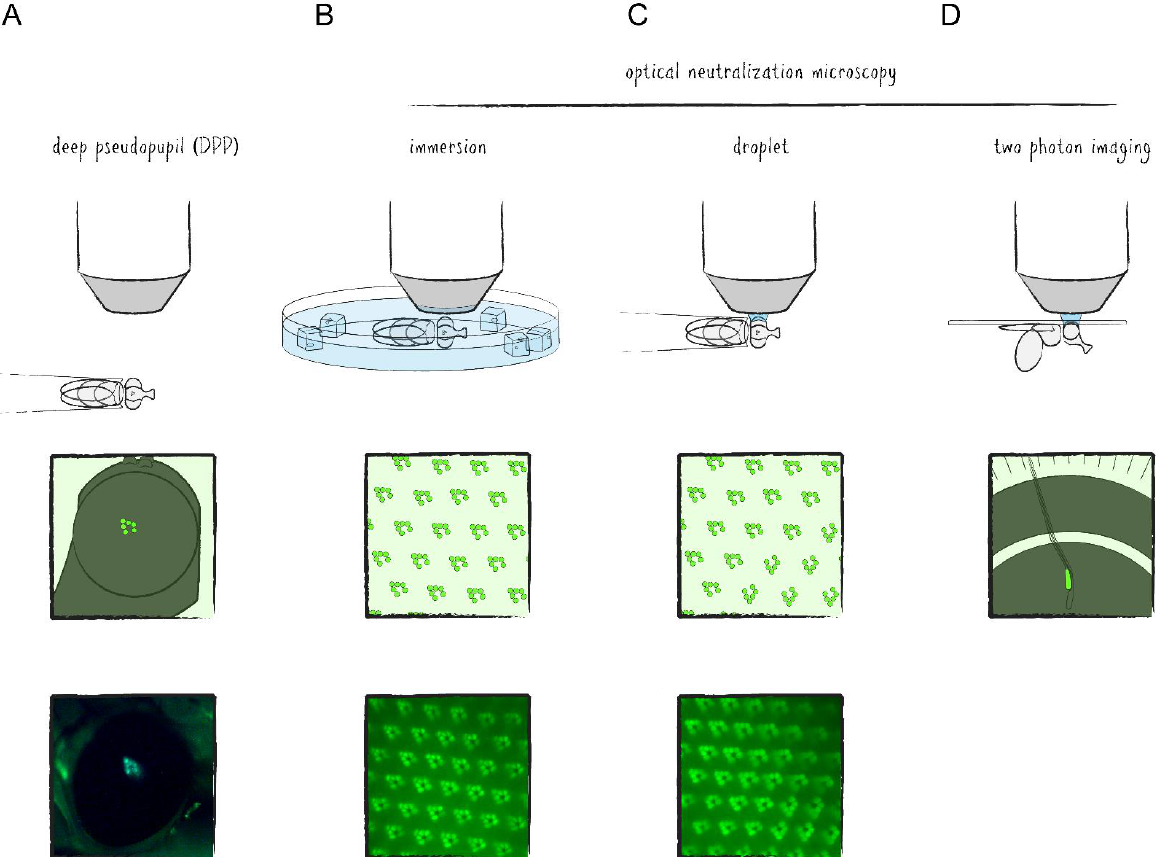
Figure 2. Illustration of common live imaging microscopy techniques of the Drosophila visual system. ( A ) A fluorescent deep pseudopupil can be visualized in anaesthetized or fixed flies by aiming a microscope objective (10 × ) slightly above or below the equator of the half spherical eye focusing approximately 180 µ m below the cornea (top). ( B , C ) Optical cornea neutralization microscopy using water immersion and cold anaesthesia (indicated by ice cubes) or a single droplet between the eye of a fixed fly and the objective (20 × ) to detect fluorescent proteins in the rhabdomeres of ommatidia (top). ( D ) Imaging of the partially dissected optic lobe by two photon laser scanning microscopy (TPLSM) using a water droplet for optical neutralization (top). Illustration (center) and micrograph (bottom) of animals that express rhabdomerally